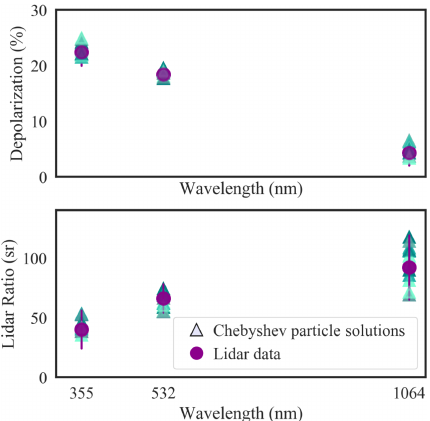
Figure 11. The reproduction of the measured PLDR and LR values, considering Chebyshev particles of the second degree ( T 2 ). Purple circles correspond to measurements performed on 22 August 2017, in Leipzig, Germany, while purple lines correspond to the measure- ment uncertainties. Different light blue colour triangles denote sim- ulations performed with the T-matrix code, assuming Chebyshev particles of the second degree ( T 2 ). Each light blue triangle corre- sponds to a different solution found to reproduce the measurements within their uncertainties, as given in Table 4. For these solutions, the deformation parameter u ranges from − 0 . 25 to 0.15, the mean geometric radius r g ranges from 0.2 to 0.5µm, and the wavelength- independent complex refractive index m takes values of 1.4 to 1.8 for mrr and 0.015 to 0.055 for